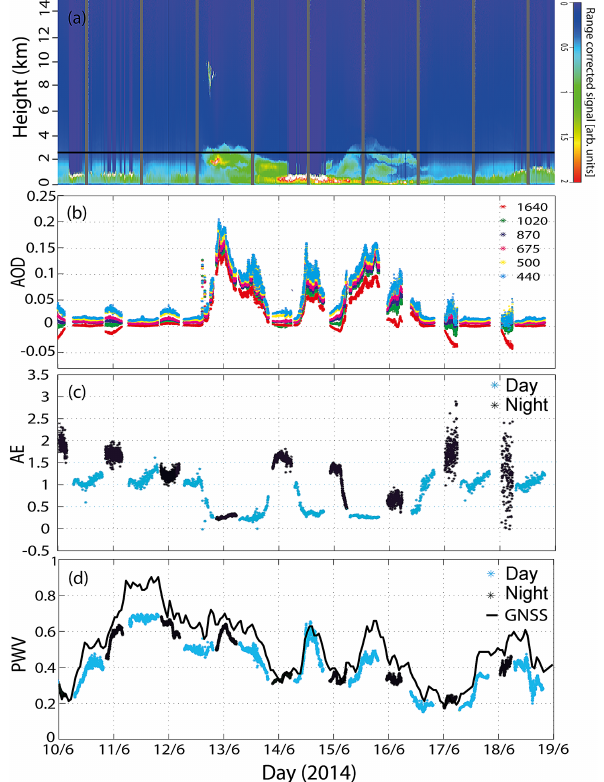
Figure 11. Case study at IZO in June, 2014, including informa- tion for (a) MPL-corrected backscatter cross section obtained from Santa Cruz de Tenerife station (60ma.s.l.). The black horizontal line represents the altitude of IZO station. Grey vertical lines repre- sent the absence of measurements. The evolution of CE318-T AOD, AE and PWV from 10 to 19 June 2014 is shown in (b) , (c) and (d) . PWV values from GNSS precise orbits are plotted with a black solid line.